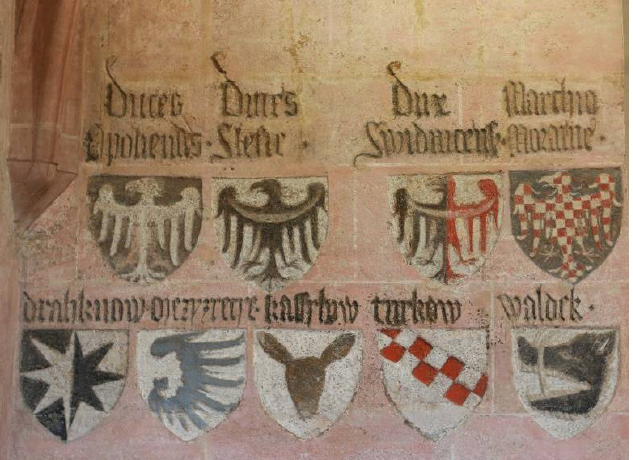
Figure 2. Lauf an der Pegnitz castle (Wenzelsburg), Vladislav Hall. Hall of arms. 1356–1360. Photo by František Záruba, the author’s own work.